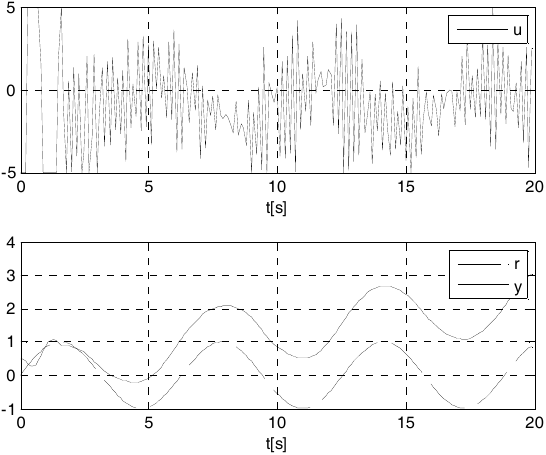
Figure A4. Time histories of u , r , and y with the MPC controller in the hypothesis of measurement noise on y  .